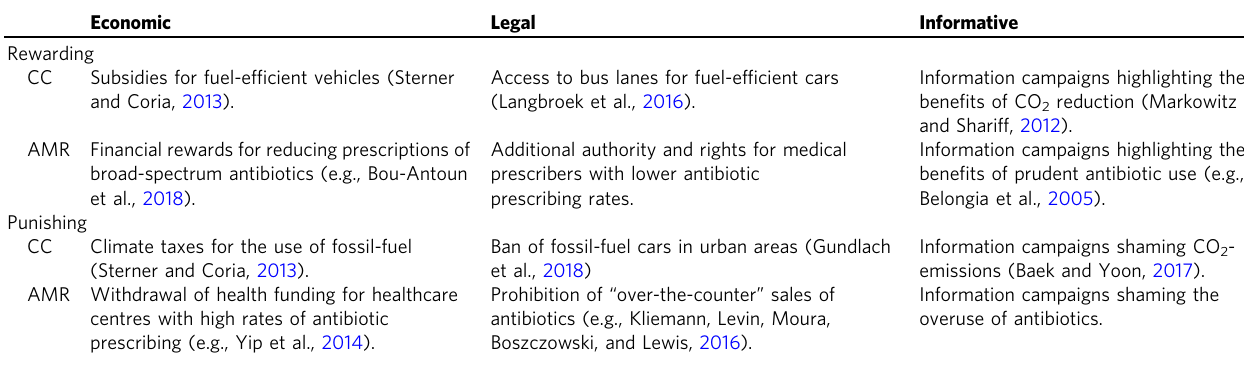
Table 1 Conceptual categorisation and examples of different policy types in the context of CC and AMR.